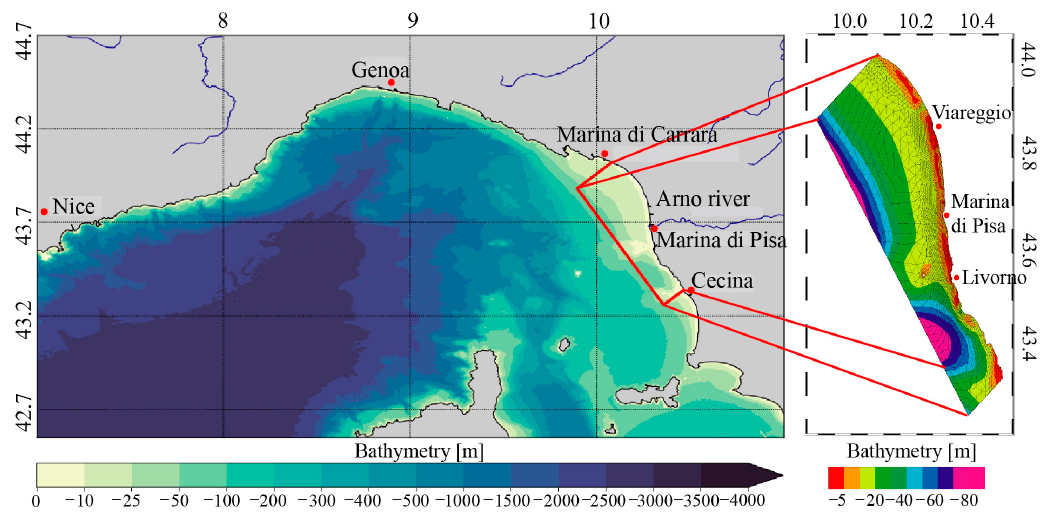
Figure 4. Left panel: study area, with superimposed EMODnet bathymetry; red polygon delimits the boundaries of the SHYFEM model implementation area. Right panel: SHYFEM model domain (horizontal mesh superimposed to bathymetry).